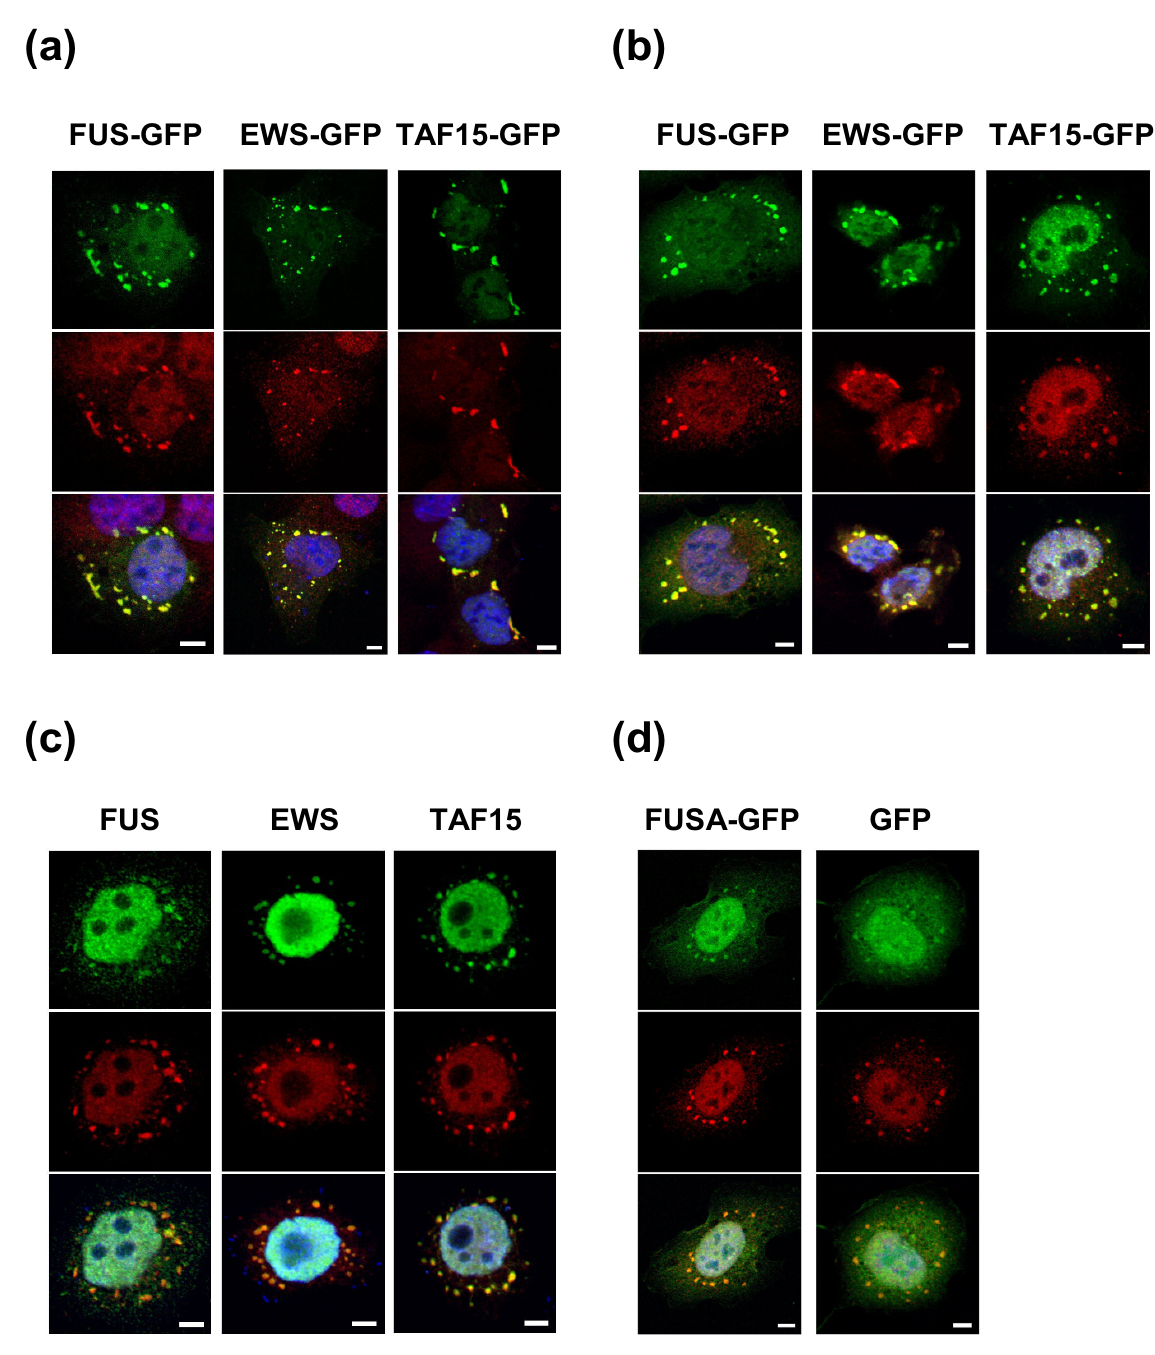
Figure 3 FET proteins localize to stress granules . Images show FET proteins (green) and immunostaining for the stress granule marker TIA-1 (red). Nuclei are visualized by DAPI staining (blue) in the bottom image of each column (a) Overexpression of FET-GFP proteins cause stress granule formation in transiently transfected HT-1080 cells. (b) HT-1080 cells stably expressing FET-GFP proteins show localization of tagged proteins to stress granules upon arsenite treatment. (c) Endogenous FET pro- teins localize to stress granules in response to oxidative stress in HeLa cells. (d) Stable transfectants of FUSA-GFP and GFP show similar minor signal in granules upon arsenite treatment. Scale bars indicate 5 μ